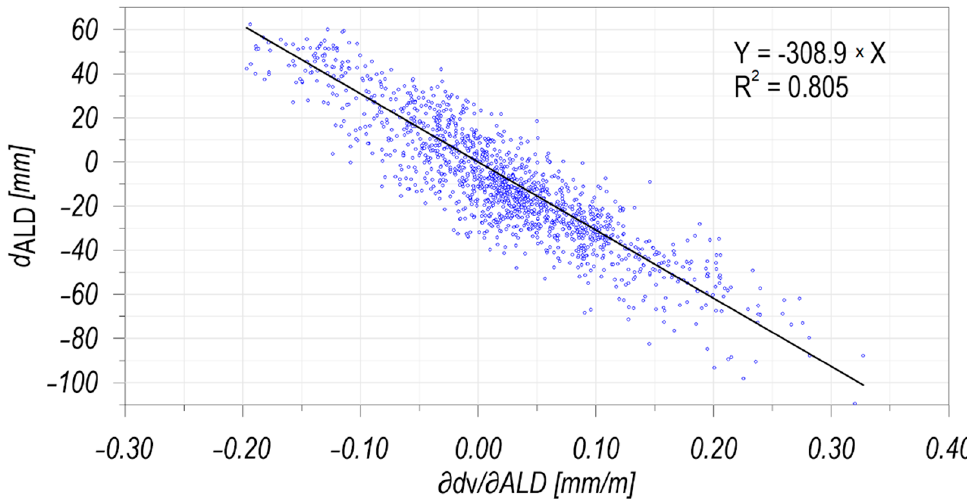
Figure 7. The relationship between ALD horizontal displacements and the directional derivative of the vertical displacement field in the case study.